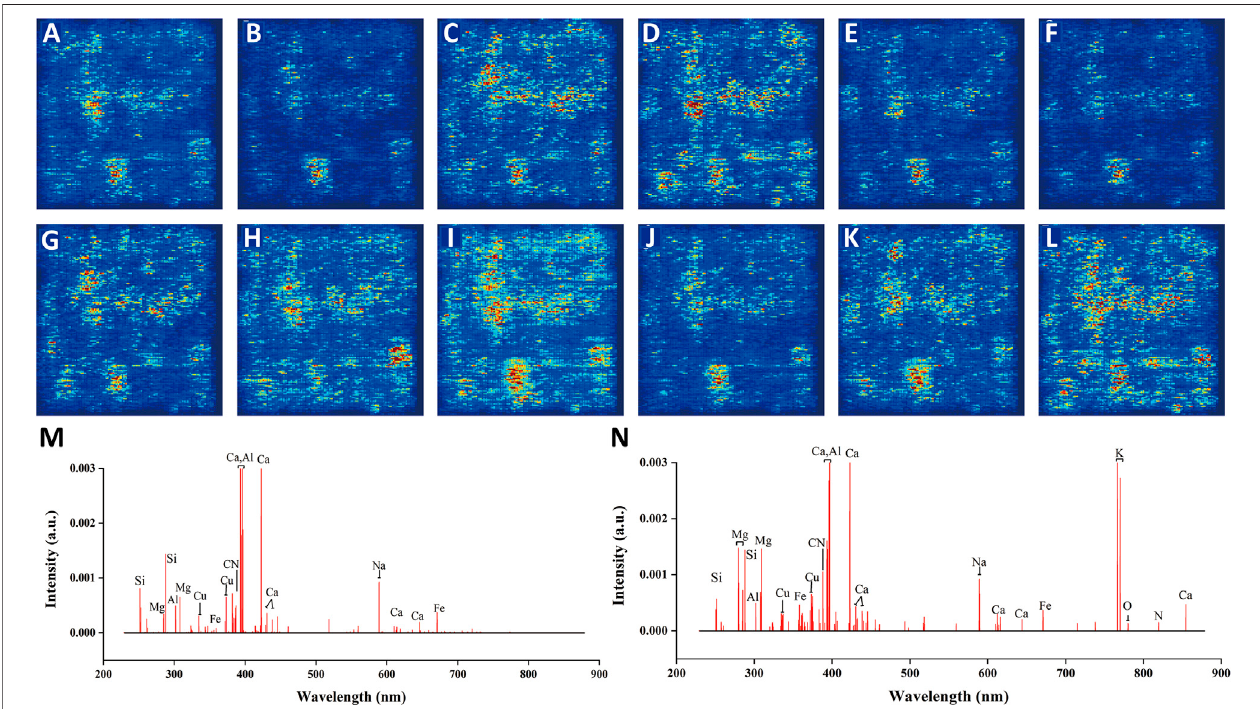
FIGURE 7 | The average saliency map of each geographical origin based on 2D-CNN for underground parts of G. rigescens Franch. (A – L) represent 12 different geographical origins. (M, N) represent the important wavelengths selected by 2D-CNN and VIM of RF, respectively.